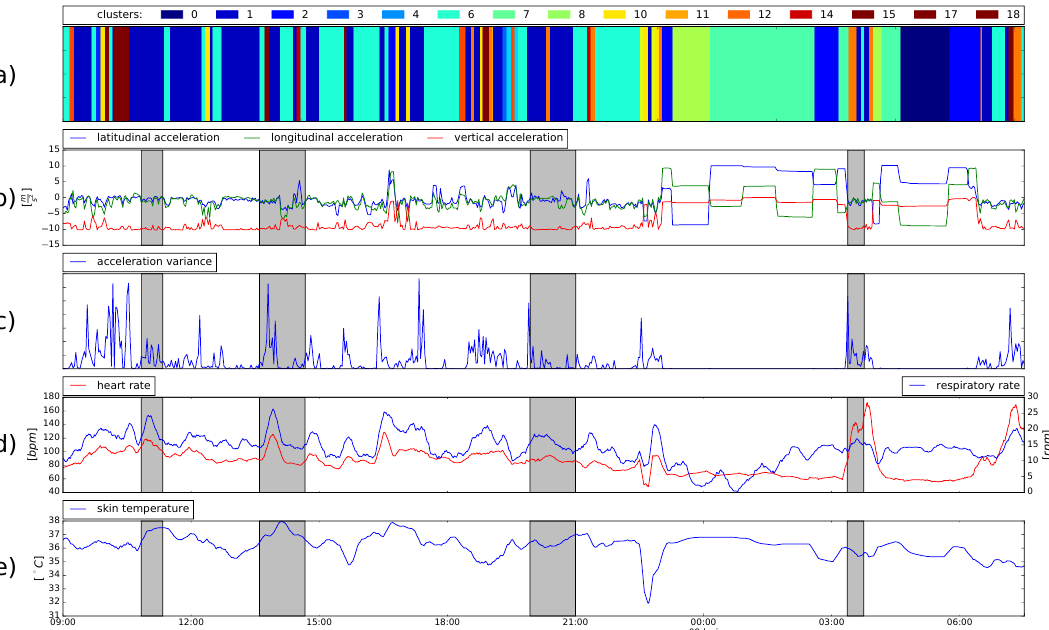
Figure 2. Exemplary data from a 24 h recording retrieved from one of the participants. Consecutive graphs (marked by subsequent letters of the alphabet) correspond to the same timeline. ( a ) depicts clusters of motion time series. Motion data consists of three-axial acceleration measurements, and acceleration variance, presented in ( b , c ) respectively. ( d ) illustrates changes in HRV (red line, left axis) and respiration rate (blue line, right axis), while ( e ) shows fluctuations in body